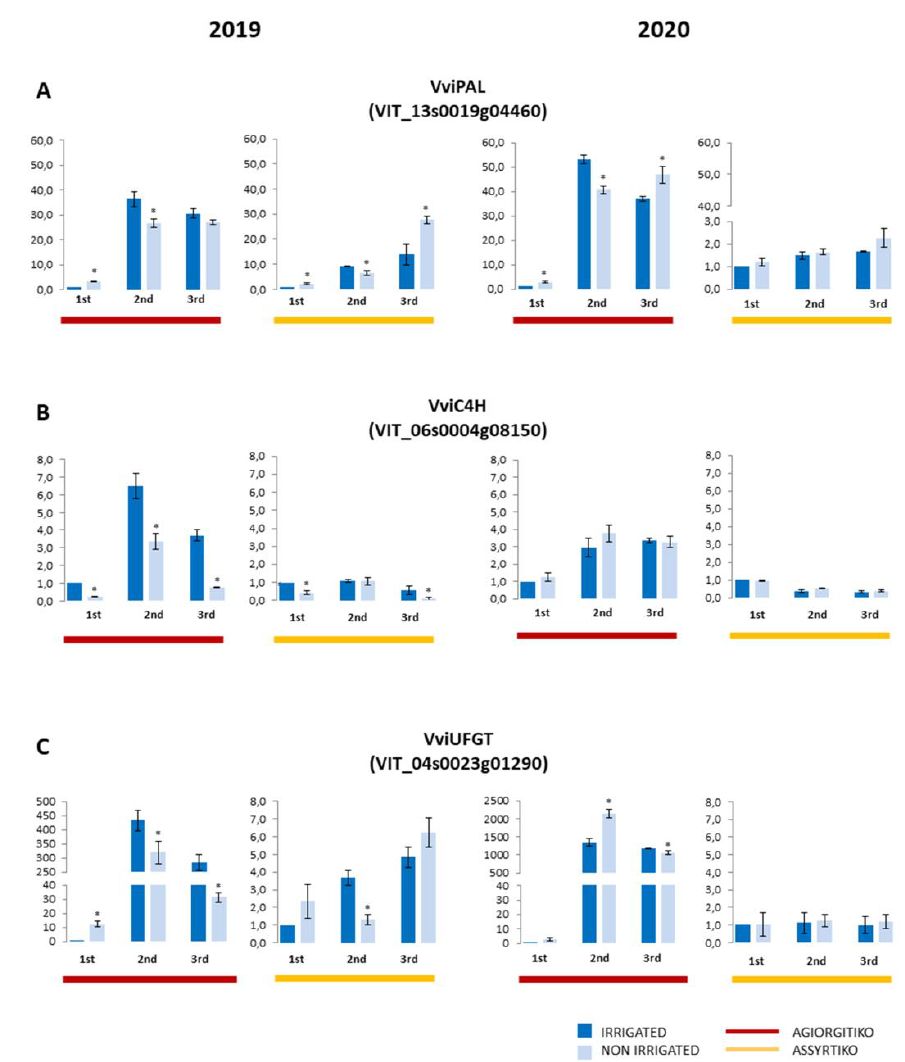
Figure 5. Expression level of genes involved in phenylpropanoid pathway (VviPAL ( A ), VviC4H ( B ) and VviUFGT ( C )) in Agiorgitiko (red bars) and Assyrtiko (yellow bars) during the two seasons of the experiment (2019 and 2020). The expression levels of irrigated plants are shown in dark blue and those under water deficit are shown in light blue. Vertical bars represent the standard deviation and asterisks indicate the statistically significant differences (Student’s t -test, * p -Value < 0.05) between irrigated and non-irrigated plants of the same sampling period. The three samples (green berry, 1st; veraison, 2nd and harvest, 3rd) are indicated under each pair of graphs.